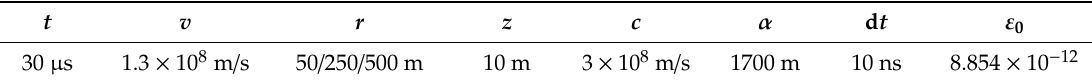
Table 2. Basic parameters used in the simulation examples.